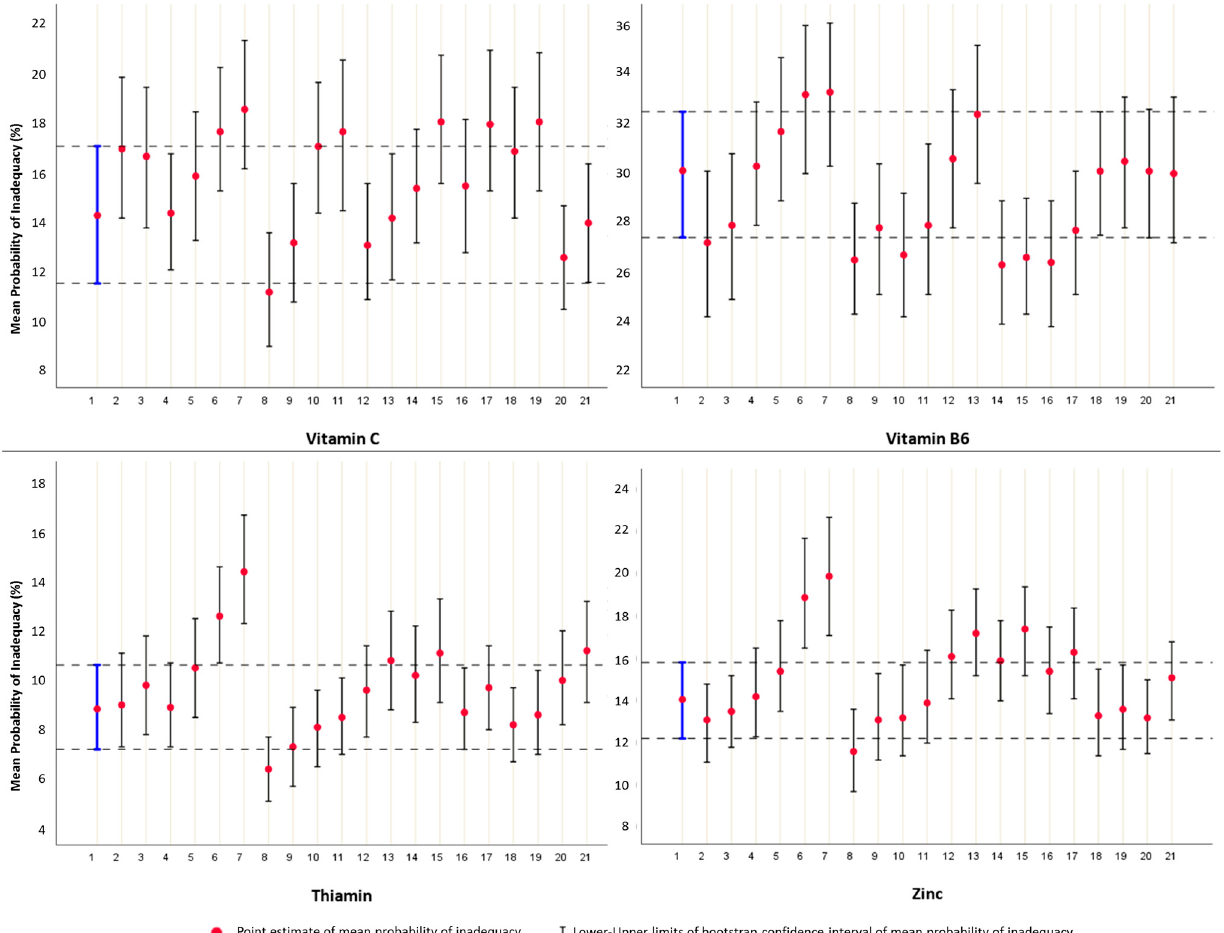
Figure 4. Point estimates and bootstrap confidence intervals for the mean probability of inadequacy (%) for vitamins C, B6, thiamin and zinc. The estimates were calculated for: 1. usual intake (blue line), and simulated datasets generated by: 2–3. the mean and standard deviation of the original values, 4–10. the combinations of lower and upper confidence limits of mean and standard deviation values of usual intakes, 11–21. random combinations of mean and standard deviation values of usual intakes, within the confidence interval limits of usual intake. Odd numbers: Scenarios without considering the uncertainty into the model; Even numbers: Scenarios with considering the uncertainty into the model.